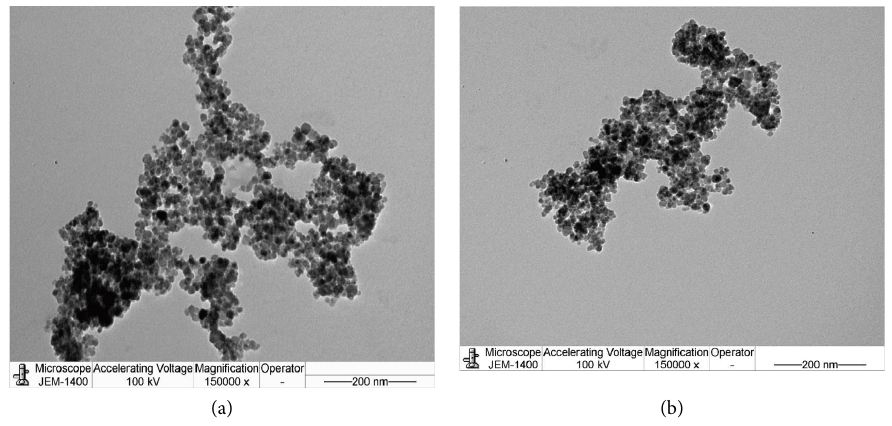
Figure 5: TEM images of (a) GO-MNPs and (b)